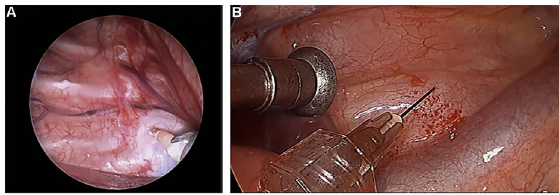
Figure 1. Representative images obtained during surgery showing ( A ) paravertebral block and ( B ) vagus nerve block in the right chest cavity. In all cases, regional block was adminis- tered under direct thoracoscopic